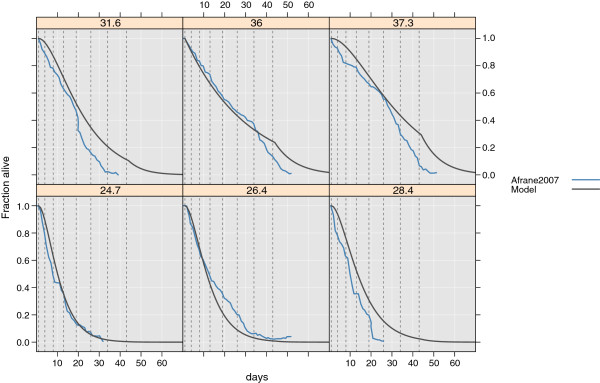
Proportion of An. arabiensis surviving at daily maximum temperatures. Estimated from Afrane et al. [112 ](blue line). Dashed vertical lines indicate the different age groups in the model (grey lines).